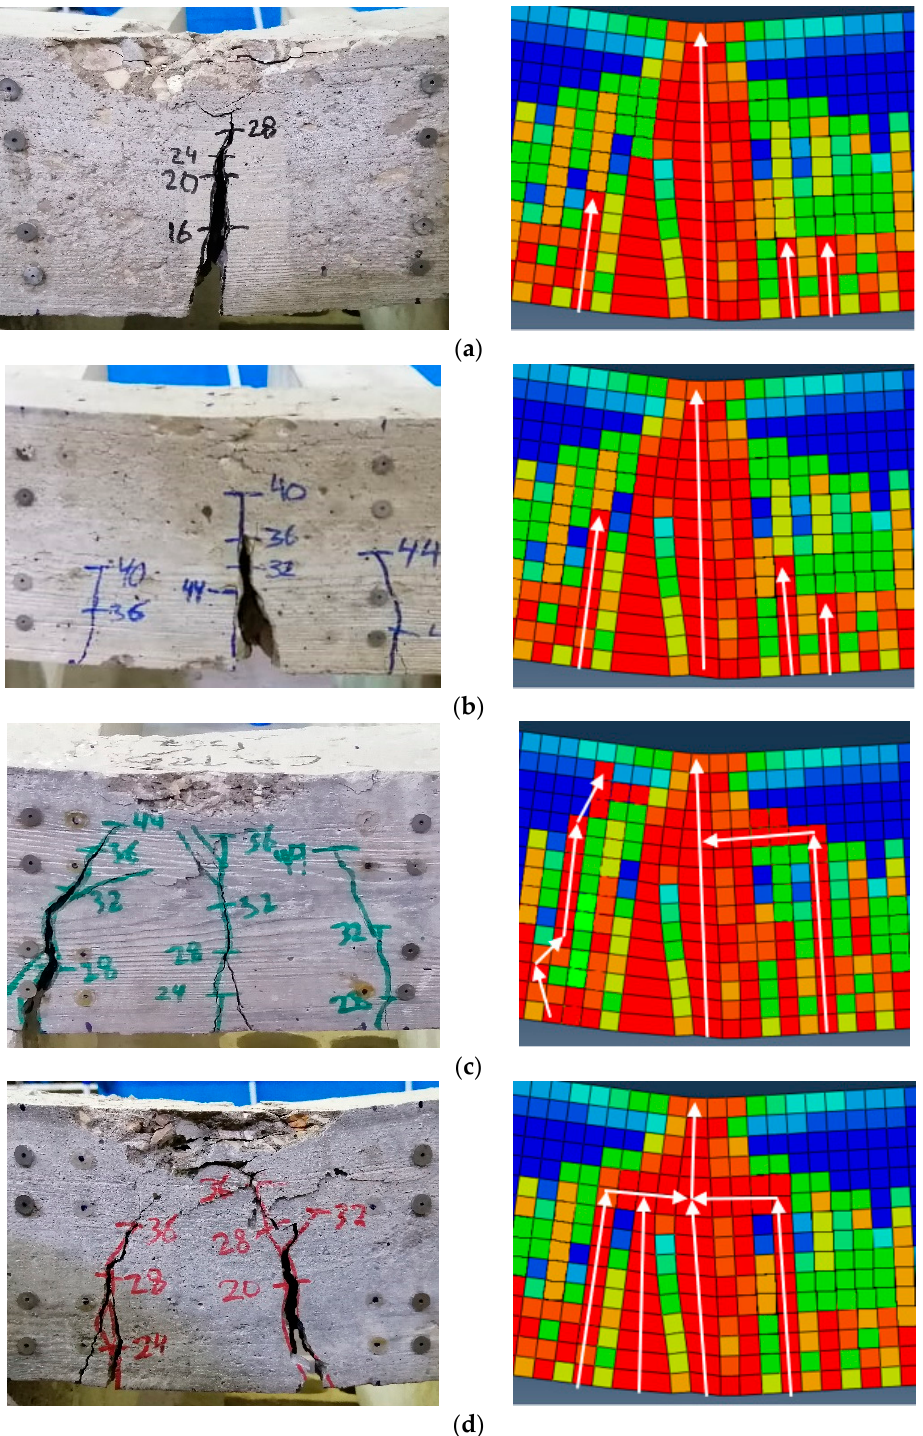
Figure 12. Comparison of tensile damage of reinforced concrete beams obtained by experimental and numerical methods for ( a ) CRT-0, ( b ) CRT-10, ( c) CRT-20, ( d ) CRT-30.